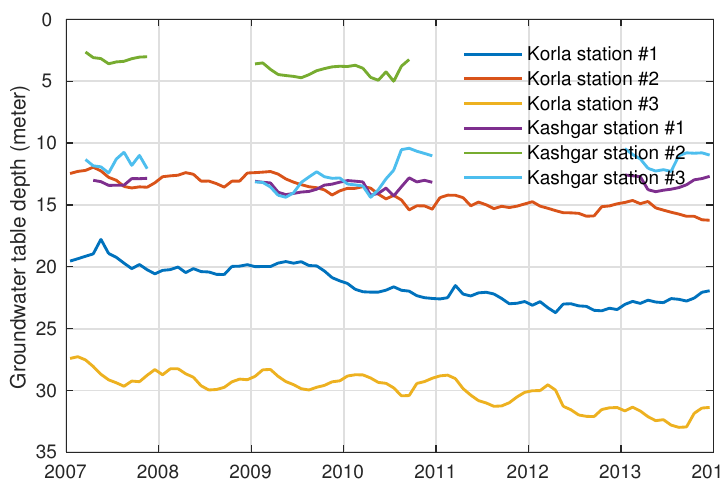
Figure 11. Time series of groundwater table depths in six wells in the Tarim Basin from 2007 to